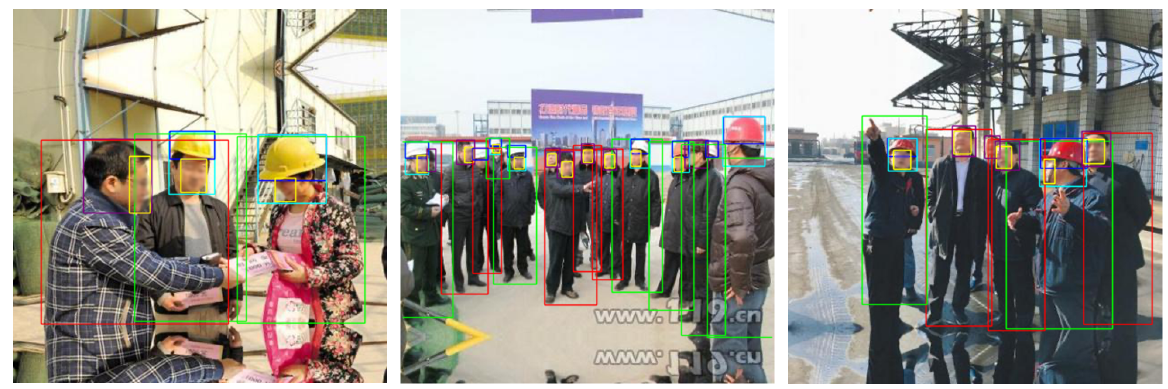
Figure 9. Result of the YOLOR [16] model experiments on the sample